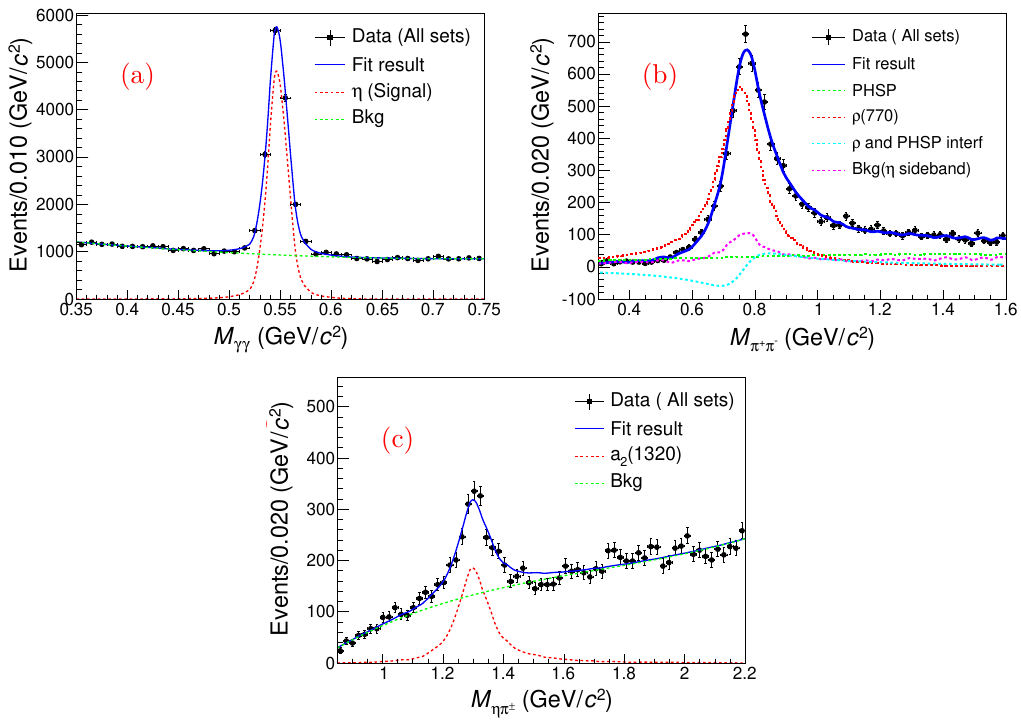
and (c) M with the sum of all energy points. The Figure 2 . Fit result of (a) M γγ , (b) M π + π − ηπ ± points with error bars are data, the blue solid lines represent the total fit, the red dotted lines represent the signal components, the green dotted lines represent the background distribution, the cyan dotted line represent the interference between ρ (770) and PHSP process and the pink dotted line represent the non- η background.